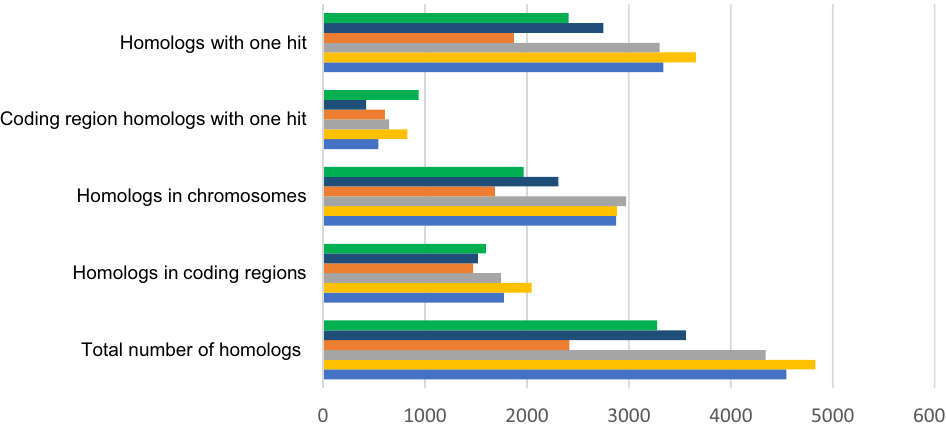
Figure 2. Quantitative summary of the comparative genomic analysis. The y-axis shows the homolog categorization depending on whether it is a BLASTN search, against the whole genome or just the coding regions and if the search only corresponds to one hit or multiple. While, on the x-axis is the corresponding count, in hits, for each of the six species. *Total number of homologs, corresponds to the totality of the 5988 SNP markers, while all the other categories, refer only to the 4529 SNP markers that were included in the genetic